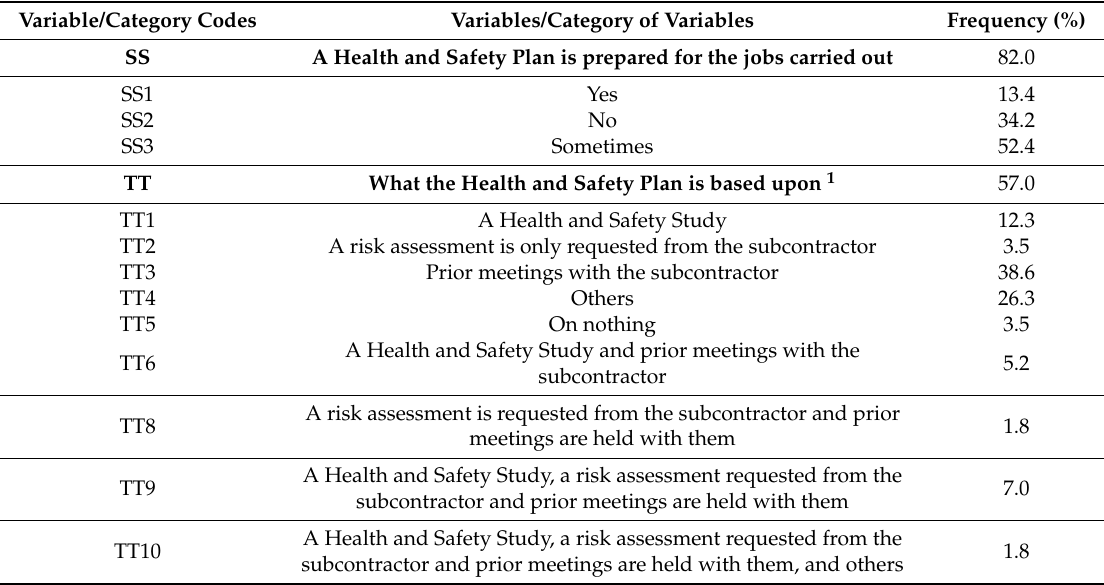
Table A6. Nomenclature and frequency of the categories of the health and safety variables for Contractor